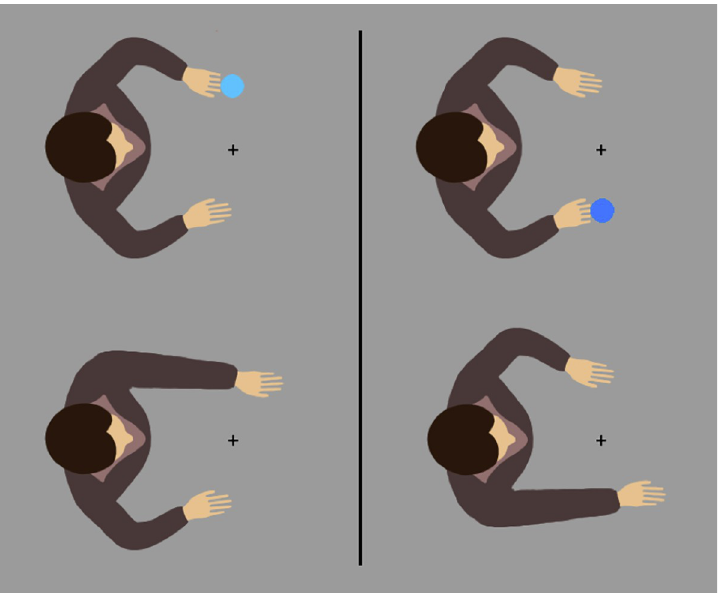
Fig 1. Avatars in Experiment 1. Avatars used in the experiment with the avatar on the left side. The top row shows the initial setup before a response was given, the bottom row illustrates the action effects.